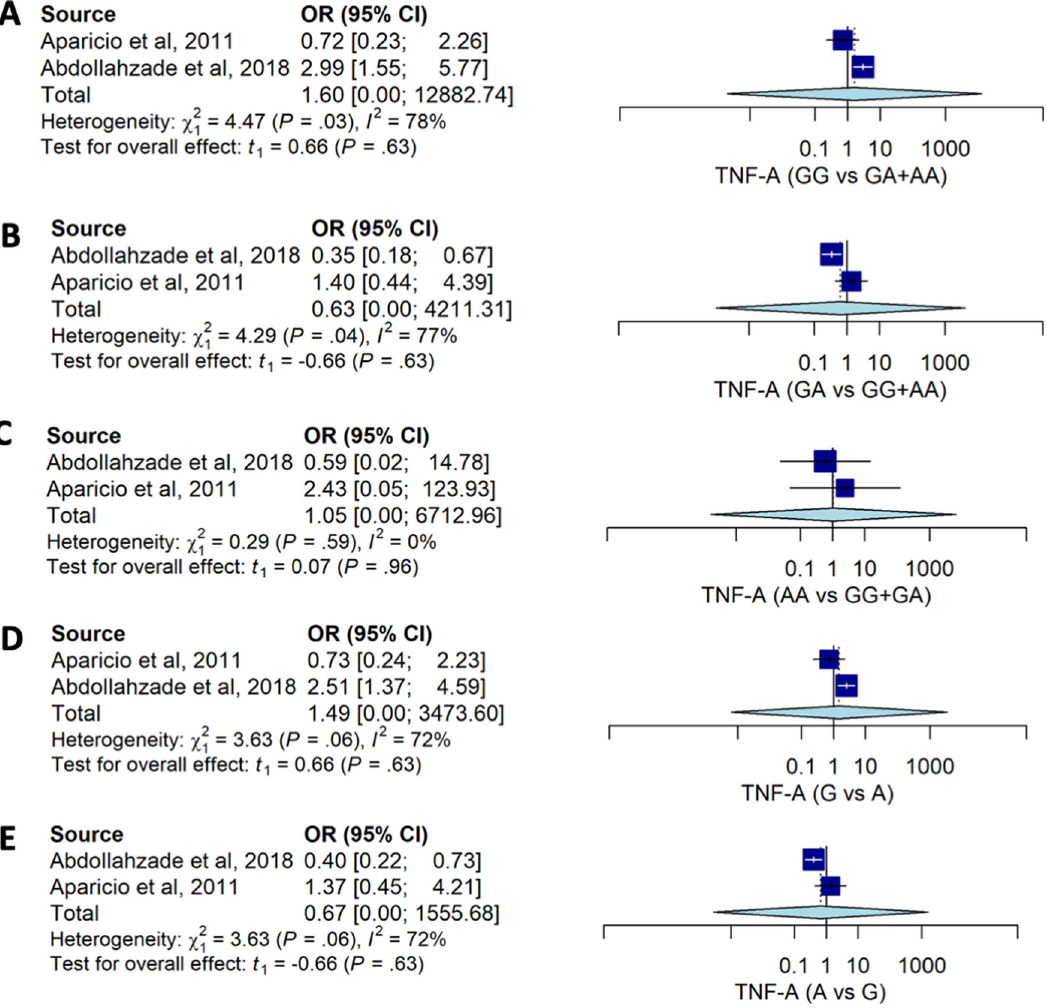
Figure 3. The forest plot of the association of TNF-A 238G>A and HNP. (A) GG vs GA+AA (OR1.60; CI95%: 0.00, 12882.74); p-value 0.628, p-Het 0.034, p-Egger 0.889, (B) GA vs GG+AA (OR0.63; CI95%: 0.00, 4211.31); p-value 0.629, p-Het 0.038, p-Egger 0.864, (C) AA vs GG+GA (OR1.05; CI95%: 0.16, 6712.96); p-value 0.955, p-Het 0.587, p-Egger <0.001, (D) G vs A (OR1.49; 95%CI: 0.00, 3473.60); p-value 0.629, p-Het 0.034, p-Egger 0.744, (E) A vs G (OR: 0.67; 95% CI:0.00, 1555.67); p-value 0.629, p-Het 0.056, p-Egger